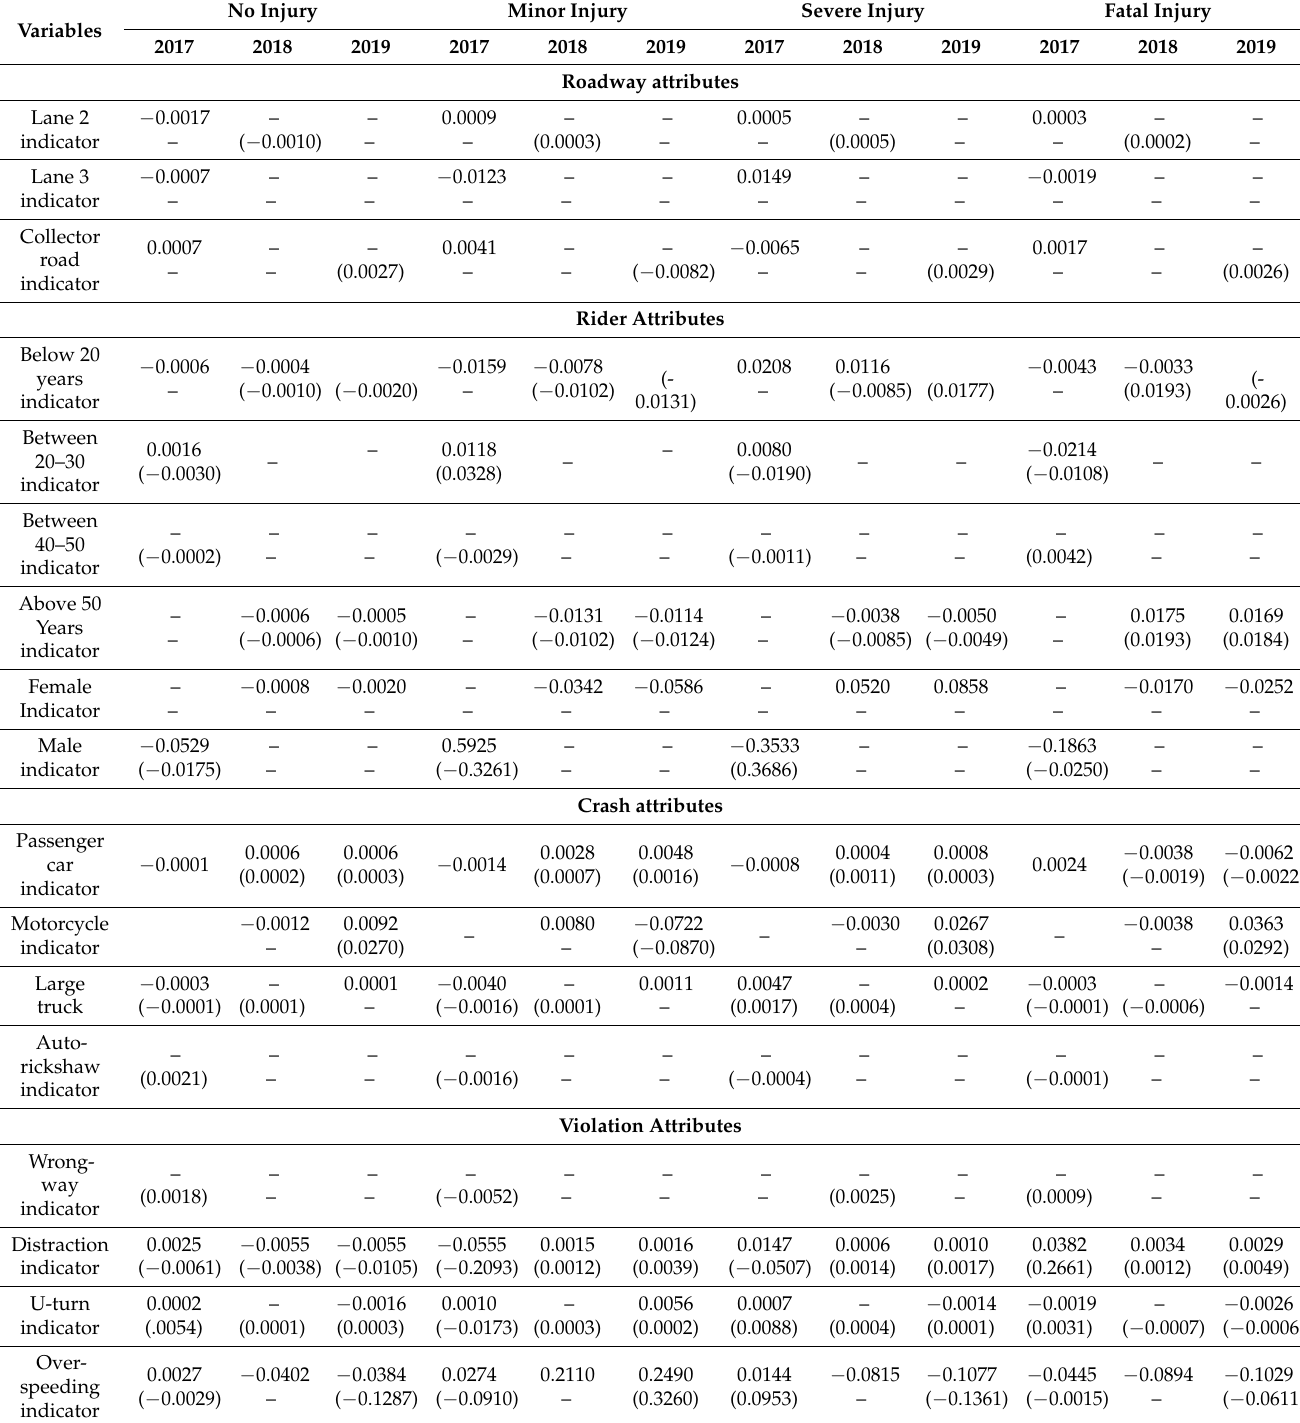
Table 12. Comparison of marginal effects in models for helmet-wearing and non-helmet-wearing motorcyclists throughout the long term (minimal impacts for non-helmet-wearing motorcyclists in